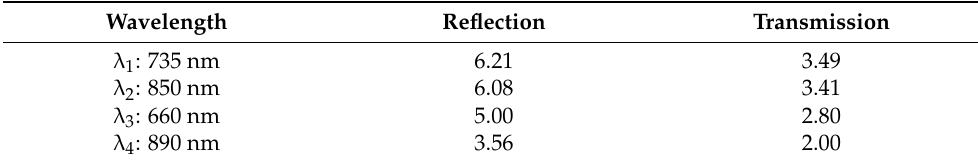
Table 2. Differential Pathlength Factor in both modes (number without unit). Wavelength Reflection